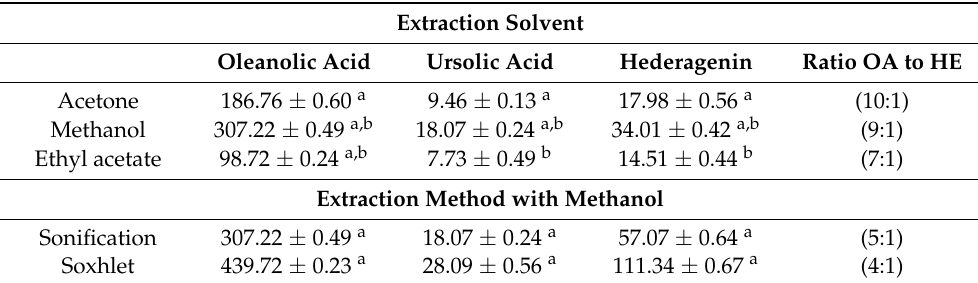
Table 6. The content of three triterpene aglycones [ µ g/g DW] in different plant material of Polyscias filicifolia cultivated in vitro and ex